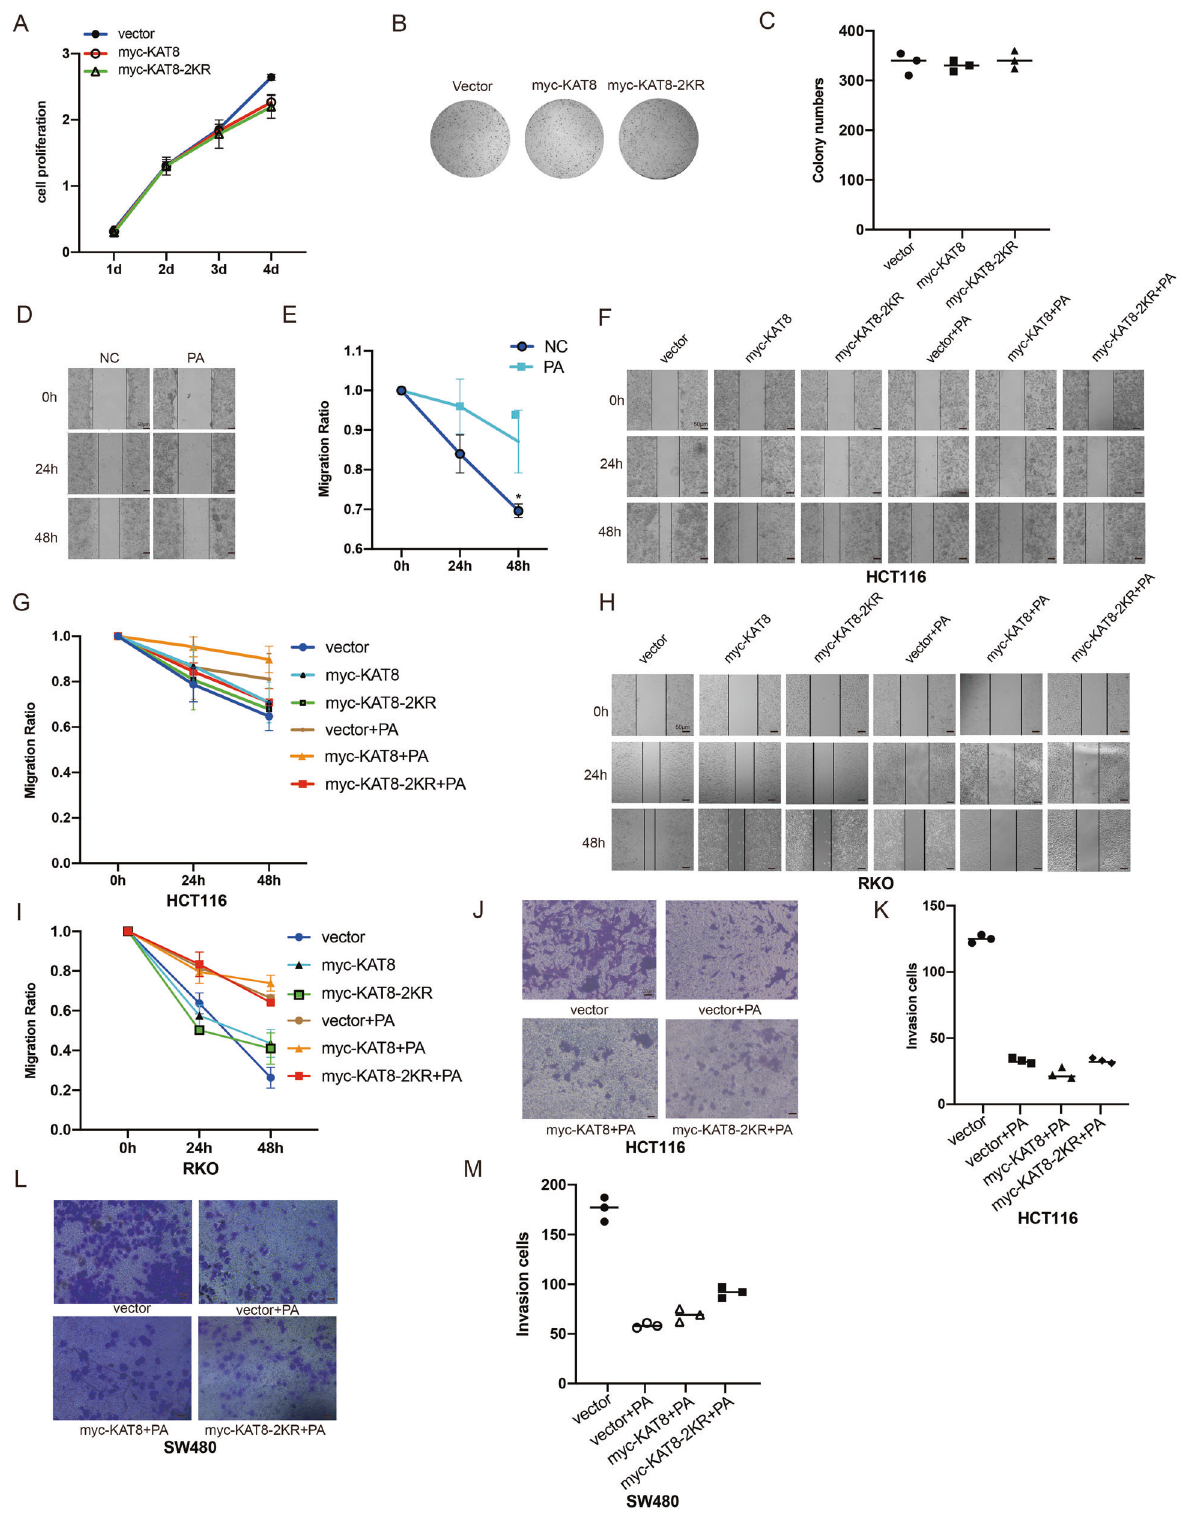
Fig. 7 KAT8 acetylation regulates migration and invasion of CRC cells. A HCT116 cells were transfected with pCMV-myc-vector, myc-KAT8- WT and myc-KAT8-2KR plasmids for CCK8 assay to generate a growth curve. B , C HCT116 cells were transfected with the plasmids